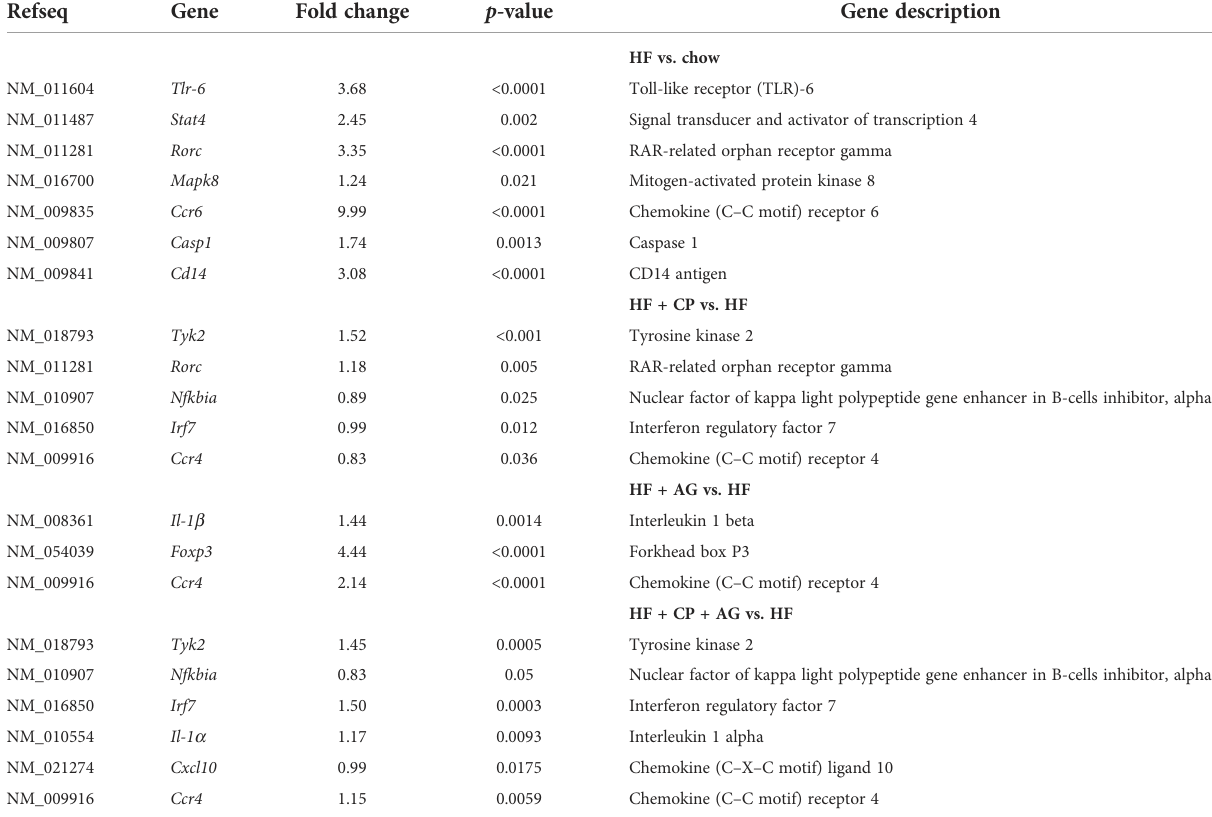
TABLE 1 PCR array results for the high-fat control group vs. treated groups.